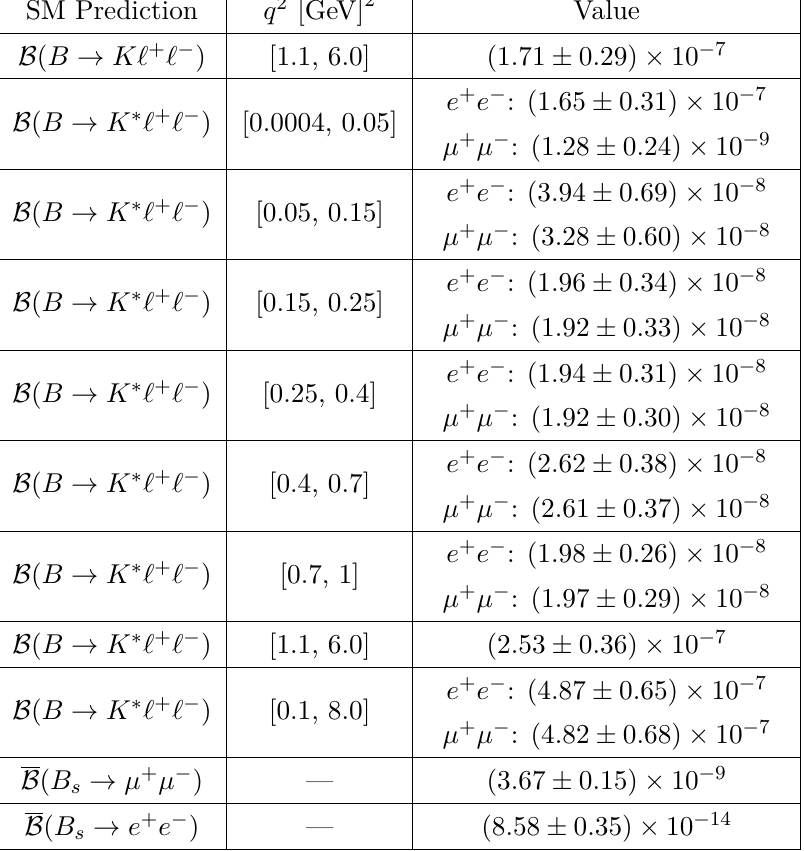
Table 4. SM predictions relevant for the analyses discussed in this work, computed directly from flavio [87].